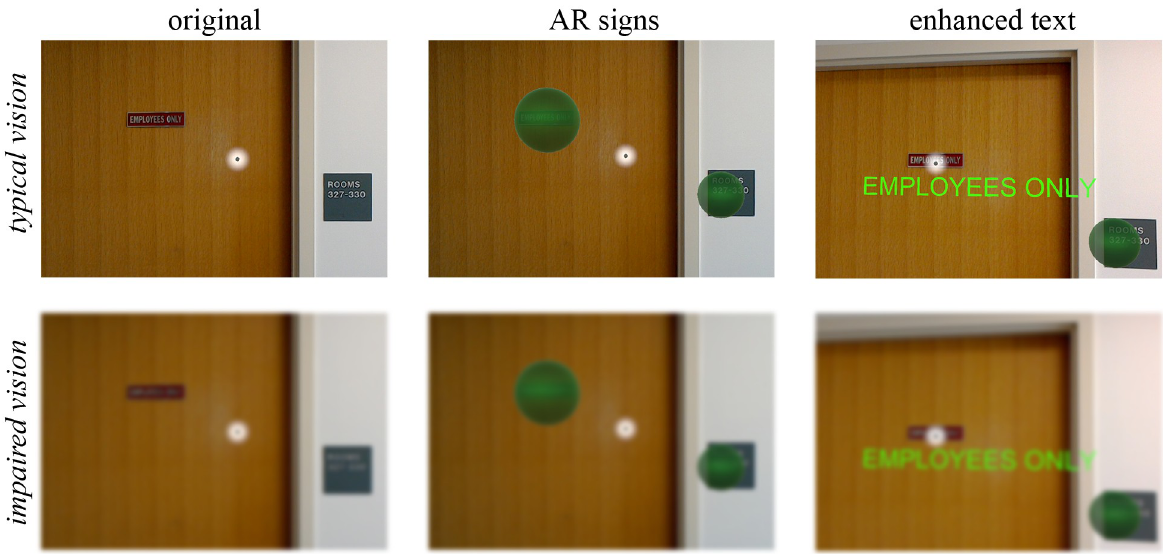
Fig 1. Application screenshots. Left column: Original view of a user looking at two signs with normal vision (top row) and simulated visual impairment via Gaussian blur (bottom row). A white circle indicates the user’s virtual cursor. Note that the signs are no longer readable with visual impairment. Middle column: Green AR signs are shown placed over the physical signs, indicating that the application identified two signs with high certainty. In real-time, these signs would be flashing at 3 Hz. Right column: Text is displayed with enhanced visibility after a user selects an AR sign.